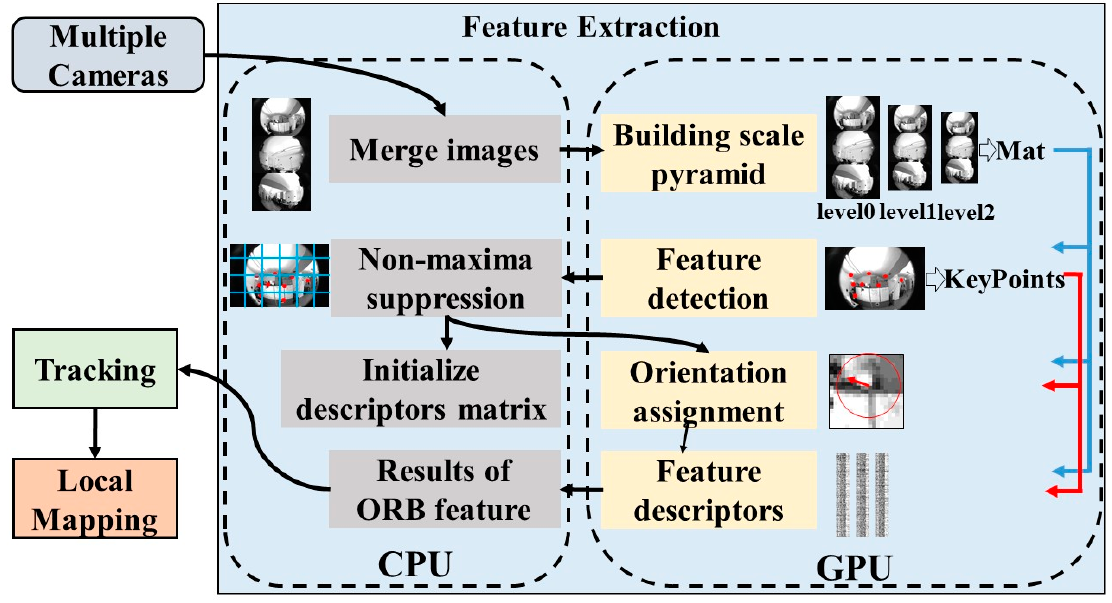
Figure 5. The framework of GPU based feature extraction. The CPU-GPU combination optimization strategy and the parallelization steps of feature extraction are shown in this figure.